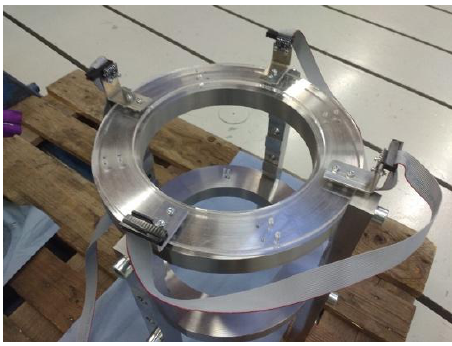
Figure 6. The top view of the Probe 37, which was also the final physical form of the